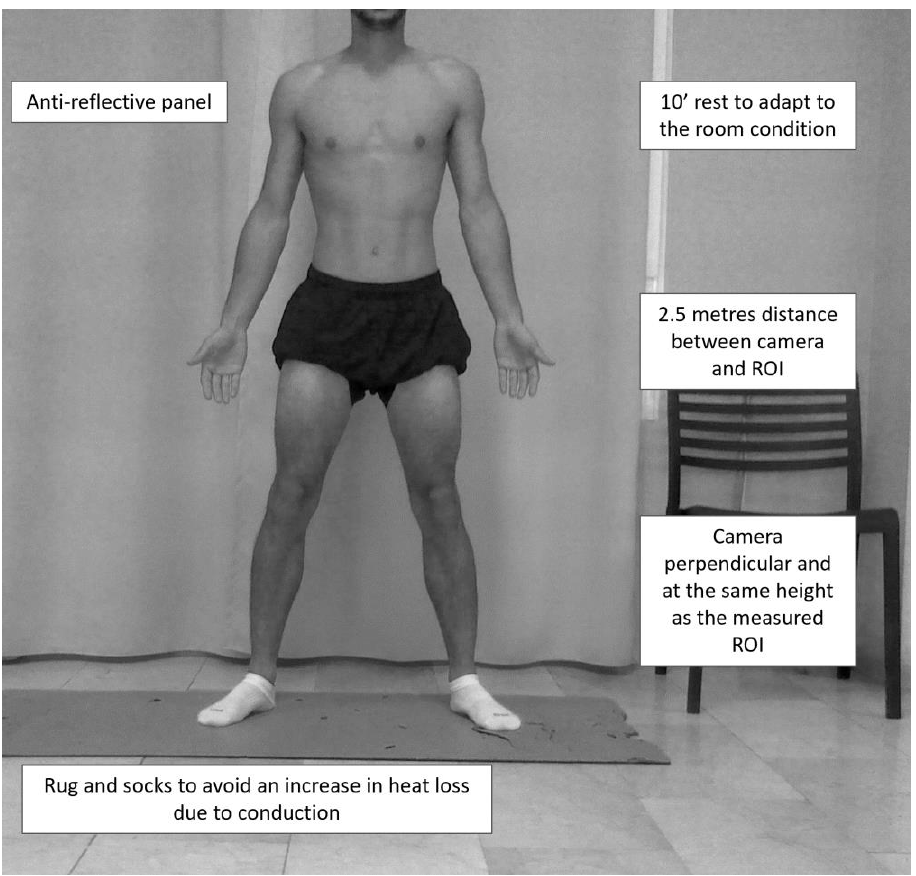
Figure 2. Methodological conditions during thermographic imaging.